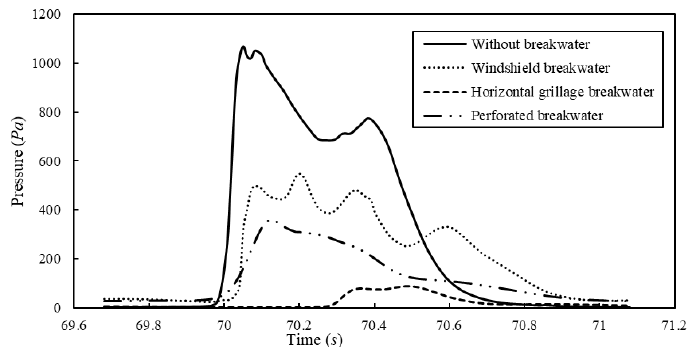
Figure 16. Impact of breakwaters on dynamic greenwater pressure variation at “PP3” on the vertical deck plate ( Aw = 0.1125 m, λ = 3.75 m).